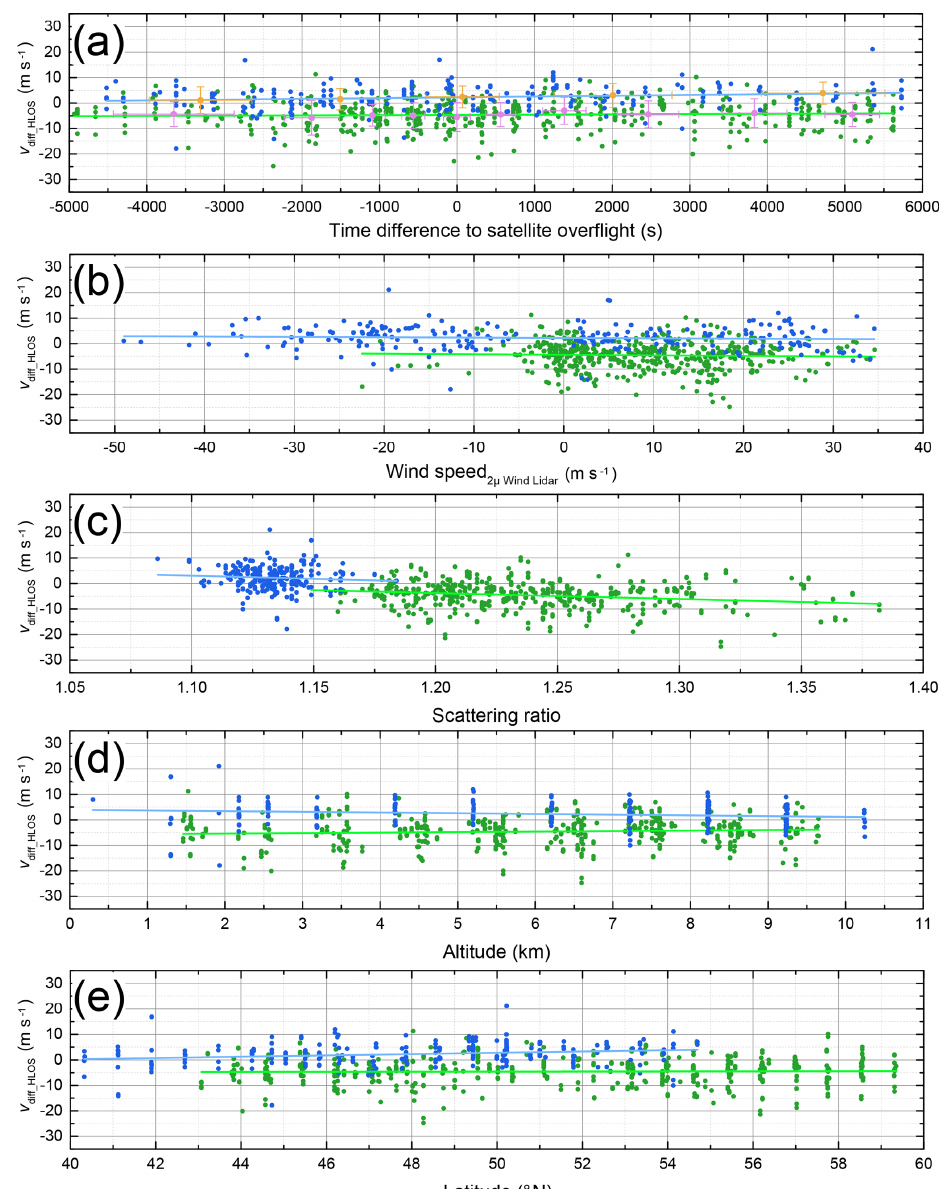
Figure 8. Wind speed difference of Aeolus Rayleigh-clear winds and 2µm DWL winds calculated according to Eq. (2) depending on time difference of 2µm DWL observation to satellite overflight time (a) , wind speed (b) , scattering ratio (c) and altitude (d) and latitude (e) . Data points of the WindVal III and AVATARE campaign are indicated in blue and green, respectively. Least-square line fits to the data points are represented by the light blue and light green lines. In plot (a) , the mean of 50 subsequent data points and the corresponding standard deviation (error bars) are show for WindVal III (orange) and AVATARE